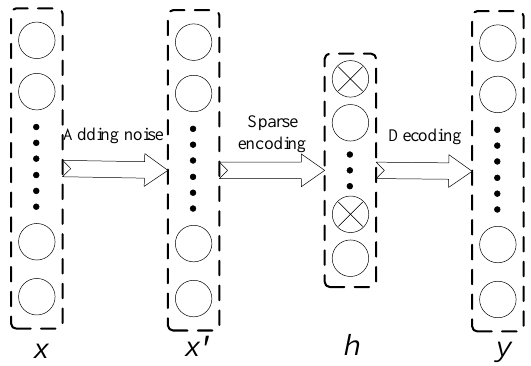
Figure 10. Diagram of DSAE network.